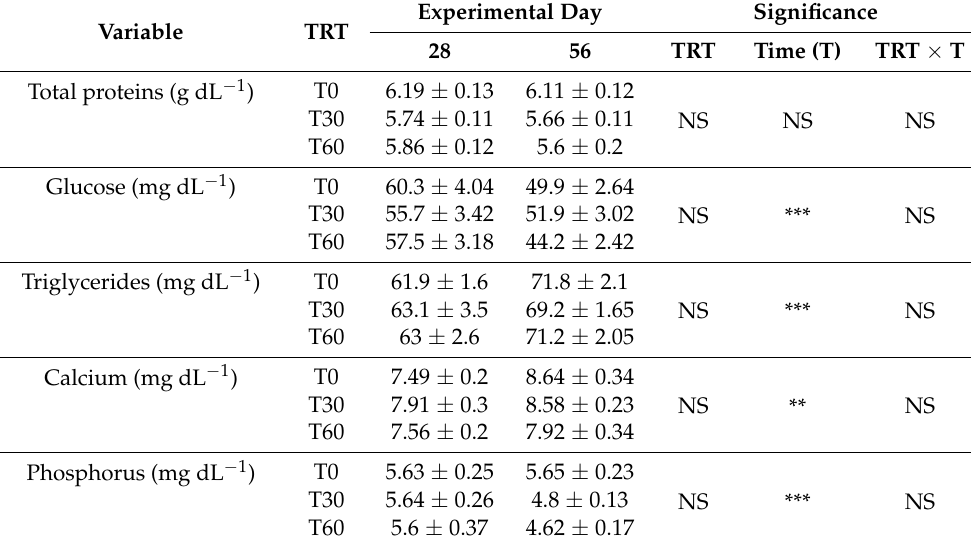
Table 4. The effect of the dietary replacement of sorghum stubble for T. recurvata on the plasma total proteins, glucose, triglycerides, calcium, and phosphorus concentration of mixed-breed goats within dietary treatment (TRT) on d 28 and d 56 of the experimental period and receiving 0% (T0), 30% (T30) or 60% (T60) of T. recurvata in the diet. Values are means ± SEM. Data for treatment analysis combined both periods. Data for period analysis combined all treatments.